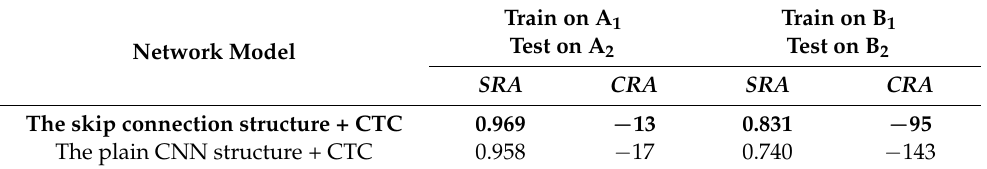
Table 3. Recognition accuracy of the skip connection structure + CTC and the plain CNN structure +